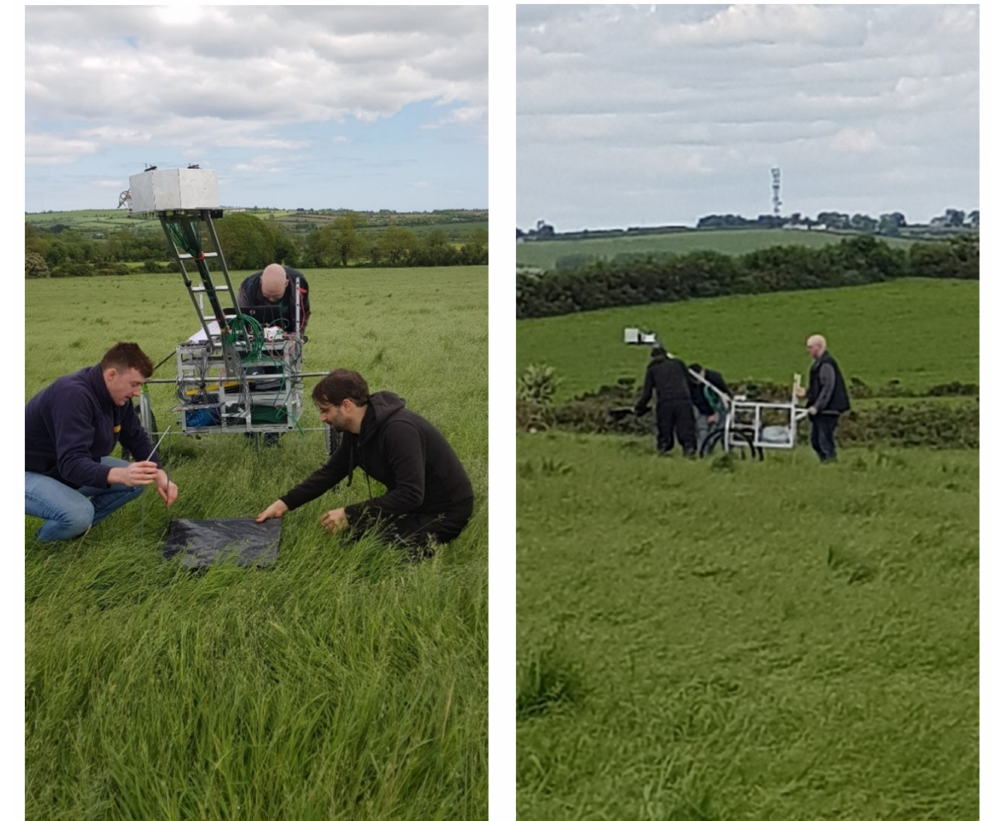
Figure 1. The sensor rig used for data